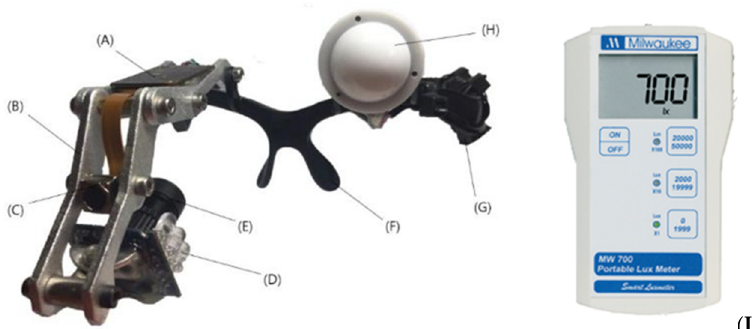
Figure 8. Pupil and light sensor headset for measuring pupil fluctuations: ( A ) tracking sensor; ( B ) aluminium arm; ( C ) target Camera; ( D ) Infrared LEDs; ( E ) pupil-tracking camera; ( F ) 3D printed ABS nose-pad; ( G ) LUX sensor UI output; ( H ) removable light sensor; ( I ) multilevel LUX meter.